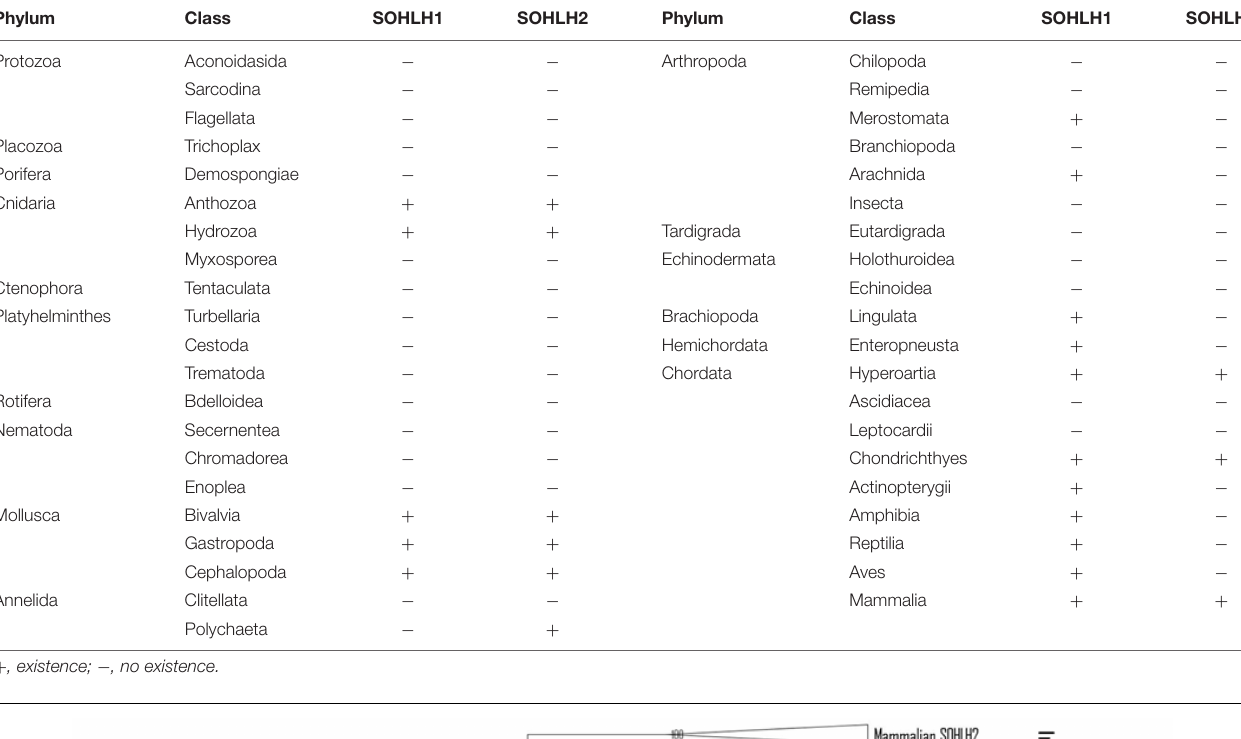
TABLE 2 | The distribution of SOHLH in genome-sequenced species.